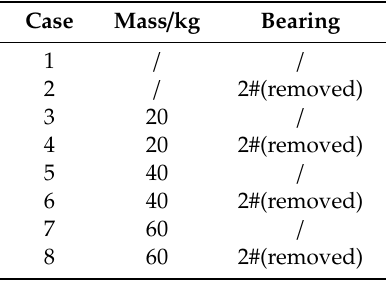
Table 6. Eight cases of the simply supported reinforced concrete plate.